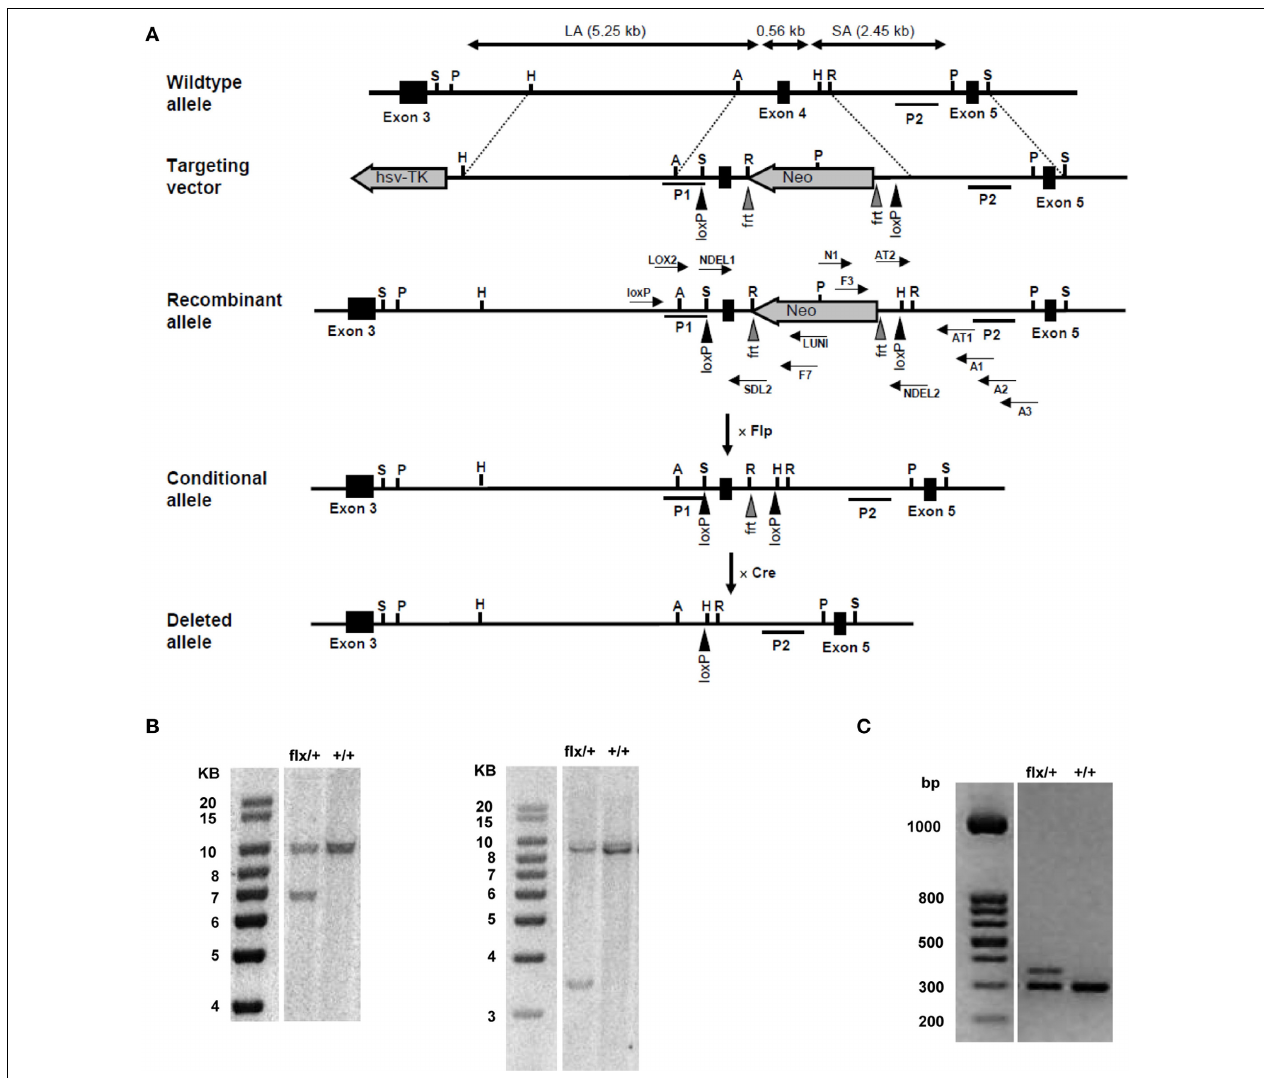
FIGURE 1 | Generation of NFAT5 conditional null allele. (A) Schematic figures of the wild-type NFAT5 allele, the targeting vector, and the targeted NFAT5 neo - flx , NFAT5 flx , and NFAT5 (cid:2) alleles. Exons are represented by open boxes in which the exon number is indicated. Black triangles denote loxP sites; gray triangles denote frt sites. The 5 (cid:2) homologous arm of the targeting vector is ∼ 5.25kb, the 3 (cid:2) homologous arm ∼ 2.45kb. P1 and P2 denote the location of the 5 (cid:2) - and the 3 (cid:2) - external probe used for Southern blot analysis. Arrows indicate the position of the primers used for gene targeting and genotyping.